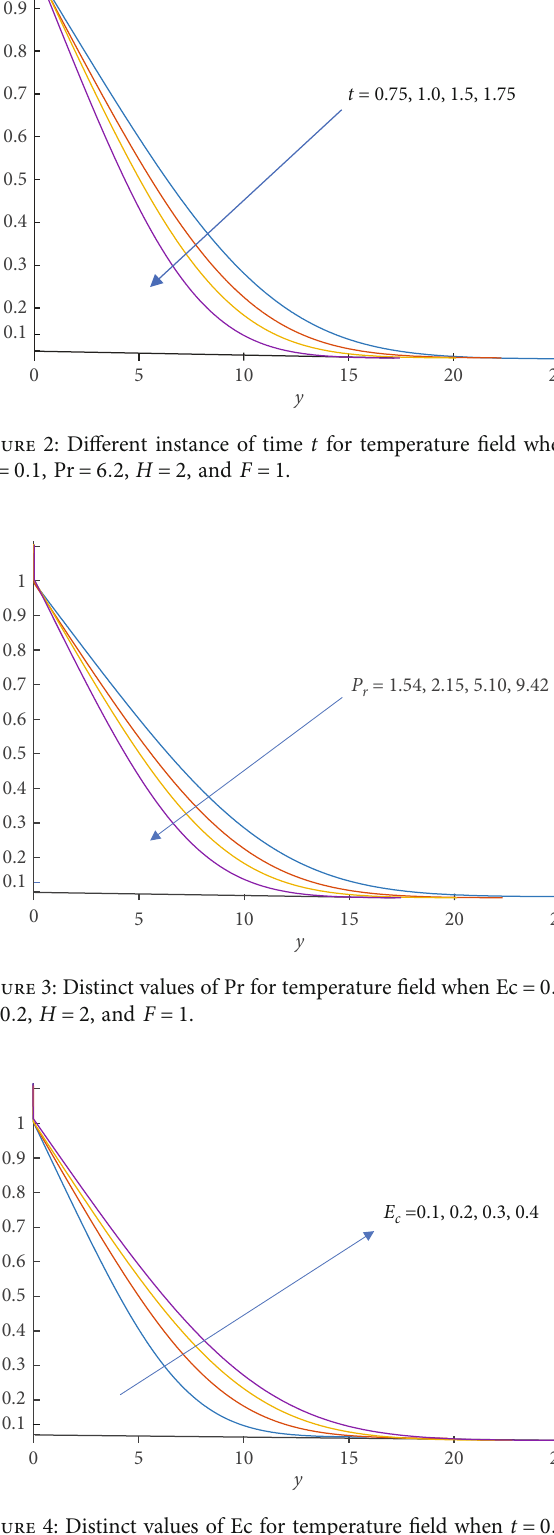
Figure 4: Distinct values of Ec for temperature fi eld when t = 0 : 2 , Pr = 6 : 2 , H = 2 , and F = 1 .